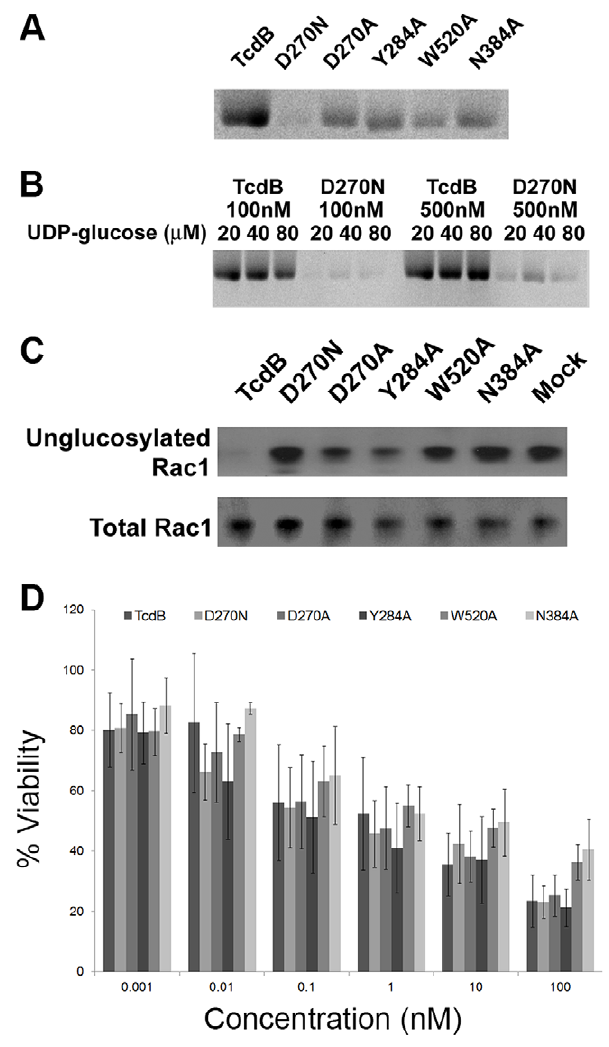
Figure 4. TcdB glucosyltransferase mutants cause epithelial cell death. A , TcdB and TcdB glucosyltransferase domain mutants (100 nM) were tested for their capacity to glucosylate purified Rac1 (2 uM) in the presence of 20 mM UDP-[ 14 C]-glucose over the course of 1 h. The proteins were resolved by SDS-PAGE, and the gels were analyzed by phosphorimaging. B , TcdB D270N was tested with higher concentrations of both toxin and UDP-[ 14 C]-glucose. Only at the highest concentrations of both toxin and UDP-[ 14 C]-glucose is residual activity apparent. C , The TcdB glucosyltransferase mutants are impaired in their glucosyltransferase activities in HeLa cells, as determined by Western and an antibody specific for unglucosylated Rac1. D , Wild-type TcdB and the TcdB glucosyltransferase mutants induced comparable levels of HeLa cell death, as determined by CellTiterGlo, after 2.5 h of treatment. Percent viability was determined by normalizing the signal from treated cells to the signal from untreated cells. Values reflect the average signal from three experiments in which each condition was tested in triplicate. Error bars correspond to the standard deviation in the percent viability from the three